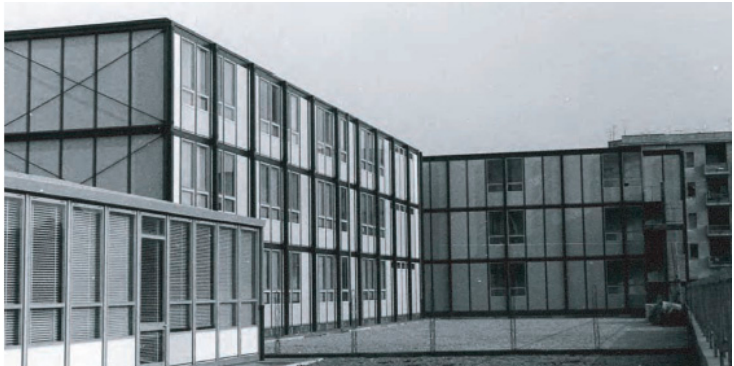
Figure 2. Picture of the school “Via Giuliano da Sangallo” in Ostia.